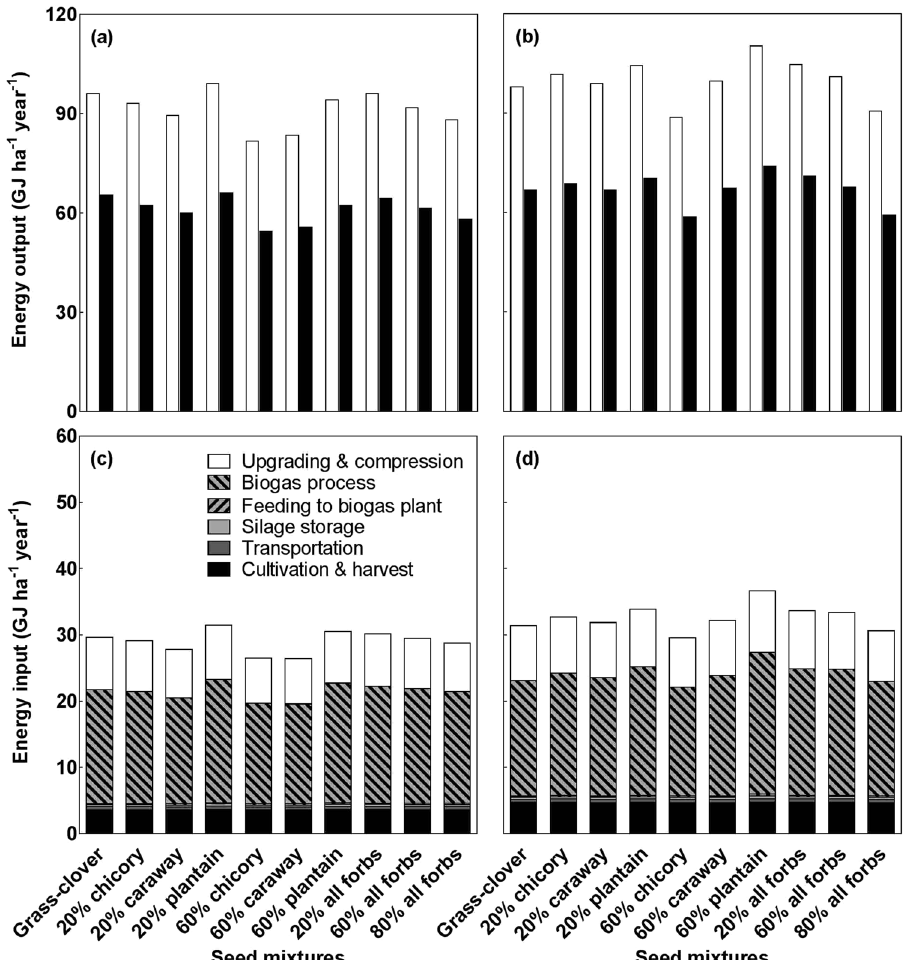
Figure 5. Energy output ( a , b ) and input ( c , d ) in the 10 seed mixtures without ( a,c ) and with fertilisation ( b , d ). Open and filled bars represent the methane energy output and the net energy balance, respectively (a , b ). Different hatched bars denote various energy inputs ( c , d ). For detailed calculations of energy output and input, please see Supplementary Text and Table